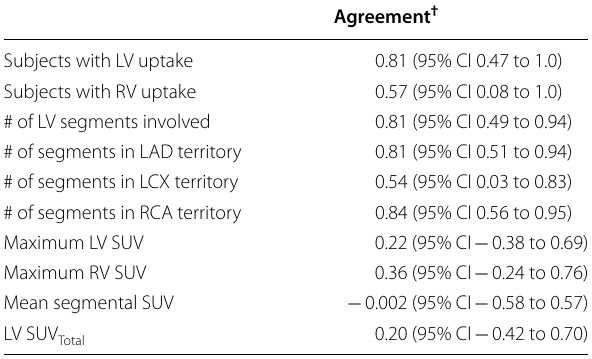
analysis of cardiac findings